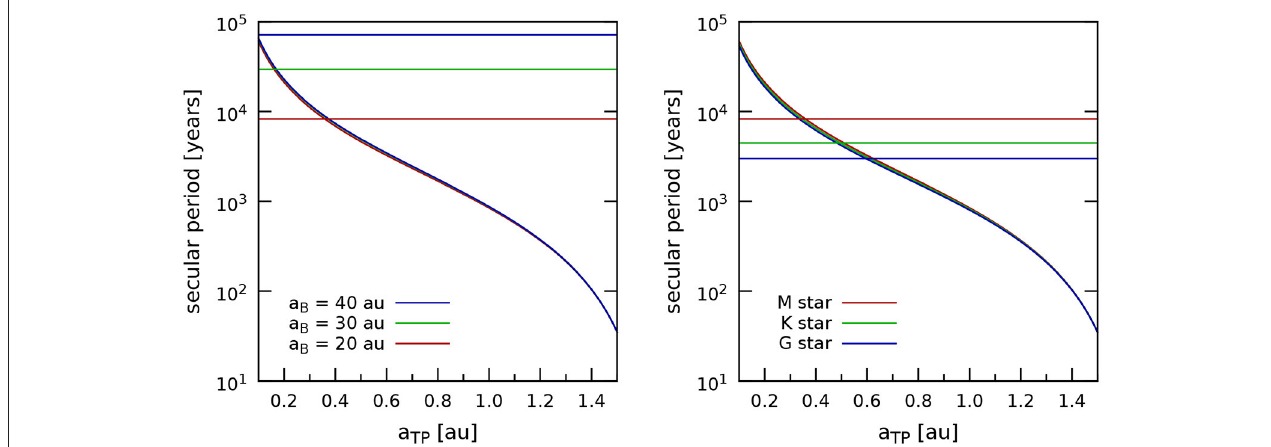
FIGURE 1 | Shows on the y-axis the proper periods either for test-planets orbiting the host-star between 0.1 and 1.5 au (x-axis) or for the giant planet (horizontal lines). These plots are the result from a study of the HD41004AB system, where the giant planet orbits the primary star at 1.64 au and the eccentricities of the binary and the giant planet were set to 0.2 in a planar configuration. Curves represent the proper periods of the test-planets in the considered area (x-axis), where the different colors belong to the binary separations of 20 au (red), 30 au (green), and 40 au (blue) in the left panel or various stellar types of the secondary star: M-type (red, 0.4 solar mass), K-type (green, 0.7 solar mass), and G-type (blue 1 solar mass) in the right panel. In both panels, the proper periods of the giant planet are given by the horizontal lines. Intersections of a curve with a horizontal line of the same color define the location of an SRs for a certain configuration. The left panel indicates the dependency of the SR location on the distance of the two stars where the SR location moves toward the host-star when the distance between the two stars increases. The right panel shows the changes due to the secondary star’s mass where the SR location moves toward the host-star if the mass of the secondary decreases. These panels are reproduced from Pilat-Lohinger et al.